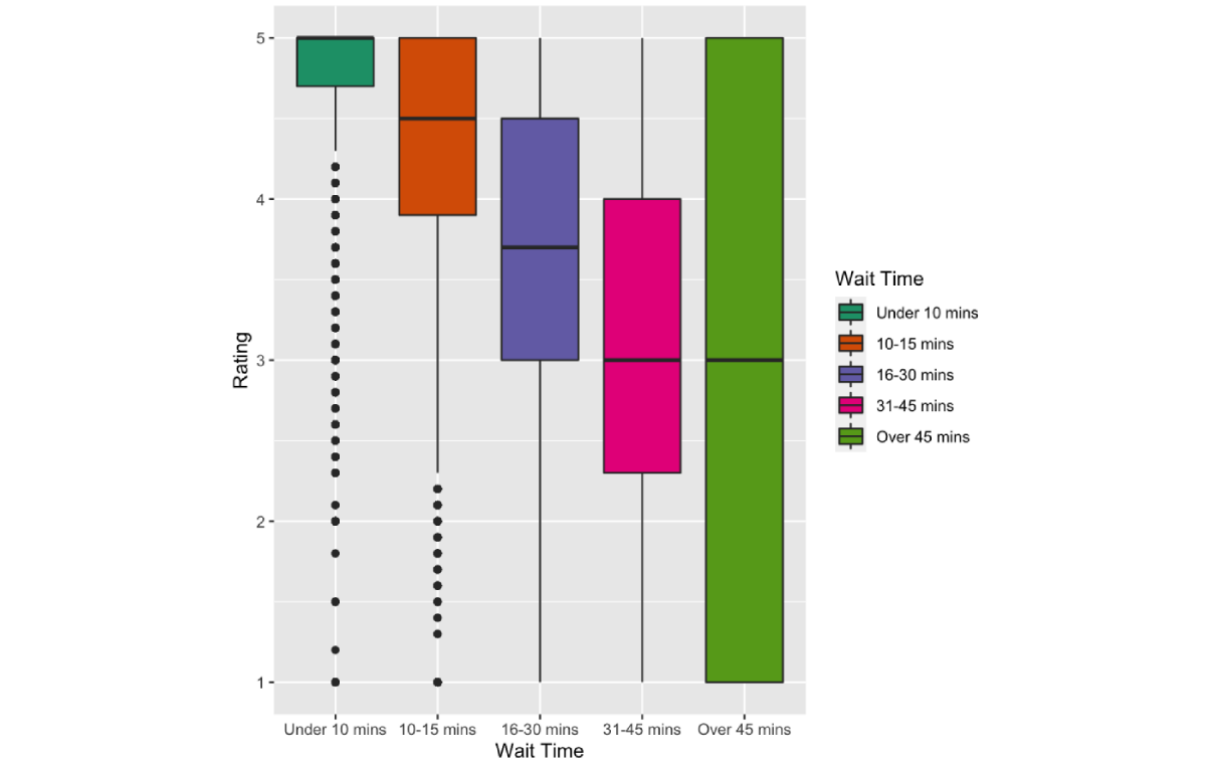
Figure 4. Overall ratings by wait